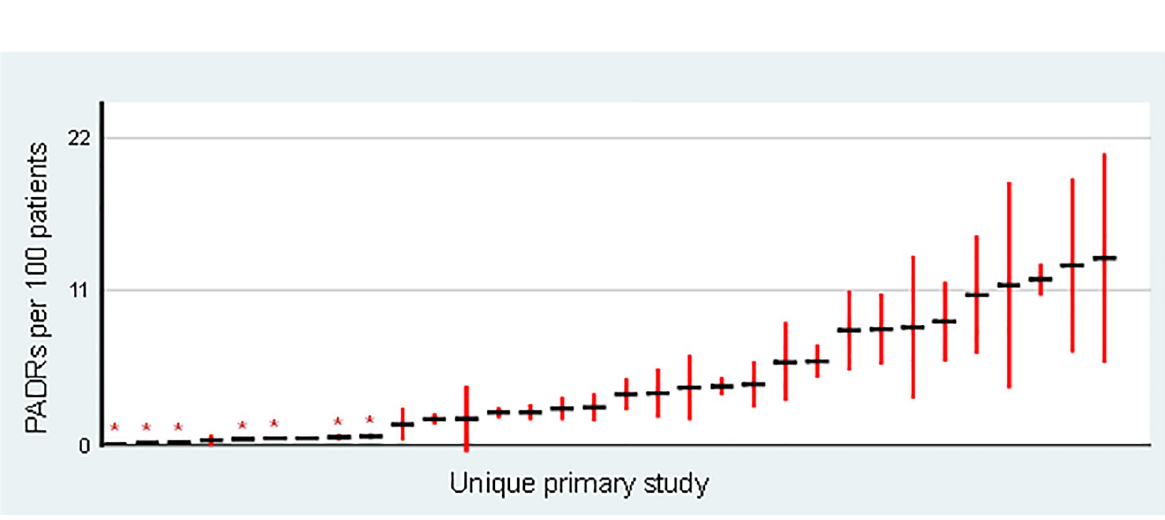
Fig 3. Scatterplot of PADR incidence rates calculated from raw data reported in primary studies, with 95% confidence intervals. Asterisks ( � ) indicate studies using voluntary/stimulated reporting alone as the event detection method. Point estimates of the PADR incidence rate for each study are represented by horizontal black lines, with their 95% confidence intervals represented by vertical red